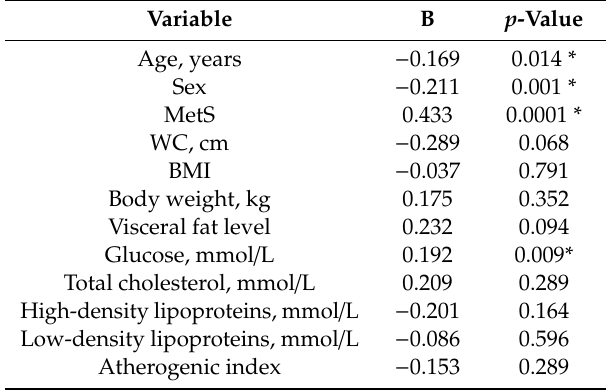
Table 6. Determinants of free thyroxine (FT4) concentrations in multiple regression